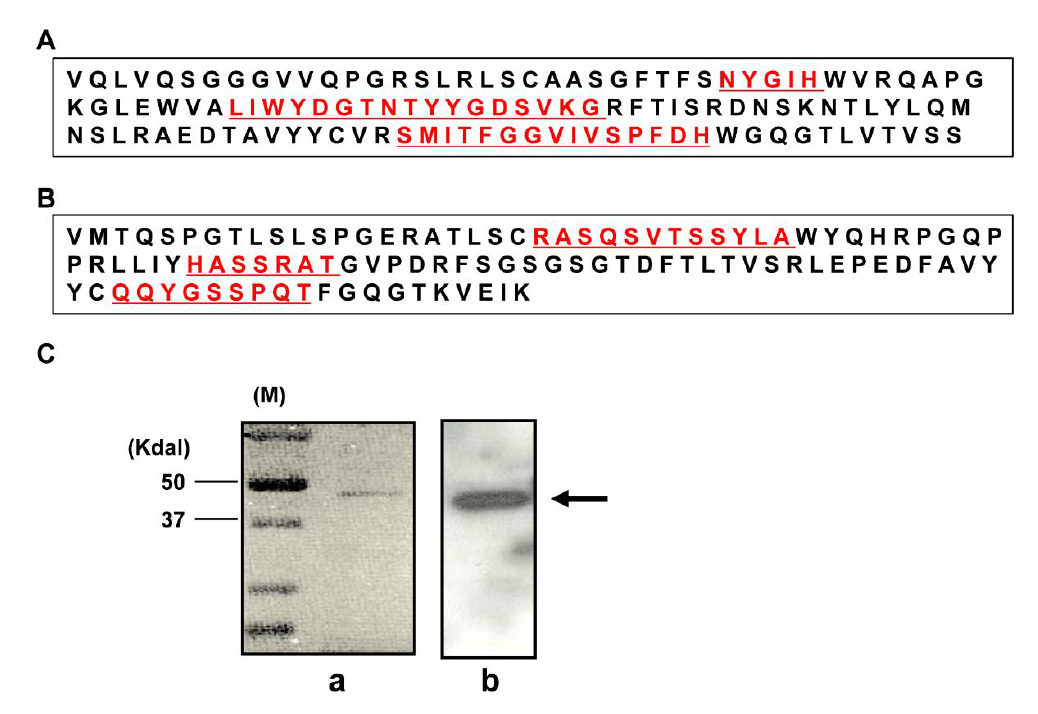
Figure 1. Amino acid sequences of heavy (V H ) and light (V L ) chains and visualization of the purified DR4-4 Fab. The amino acid sequences of the V H ( A ) and V L ( B ) regions of DR4-4 Fab are available from European Molecular Biology Laboratory / GenBank under accession numbers JN030159 (V H ) and JN030158 (V L ). The purified DR4-4 Fab (1 µ g / mL for immunoblotting and 10 µ g / mL for Coomassie